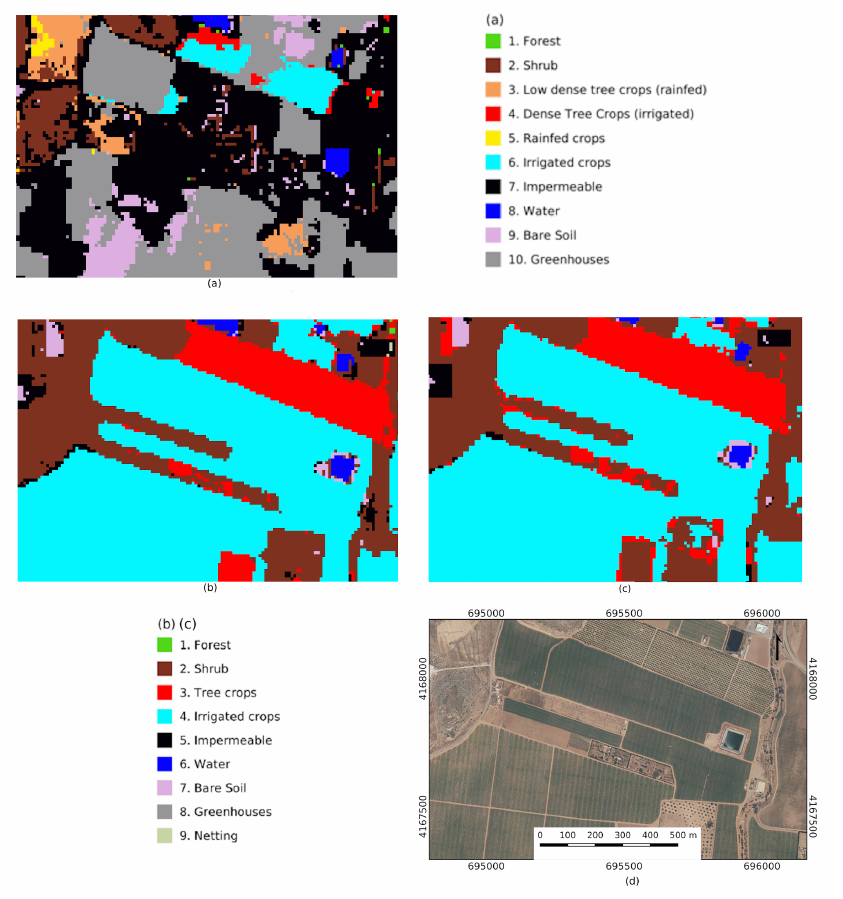
Figure 10. Example of improvement in classification: ( a ) classification with S2 and indices in previous study [60]; ( b ) same area classified in the present study with S1 and S2; ( c ) same area classified in the present study with S1, S2 and LiDAR; ( d ) ortho-photography